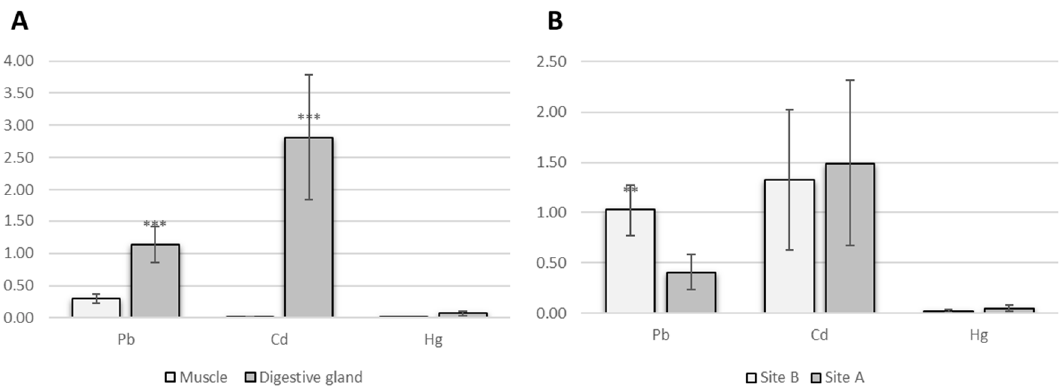
Figure 2. Concentration of Pb, Cd and Hg in O. vulgaris depending on ( A ) organ type: muscle versus digestive gland; ( B ) sampling sites: Napoli versus Castellammare di Stabia. Vertical bars represent average concentration (µg g − 1 wet weigth) ± SEM. Probability levels for significant differences: p < 0.001(***); p < 0.01 (**); p < 0.05 (*).